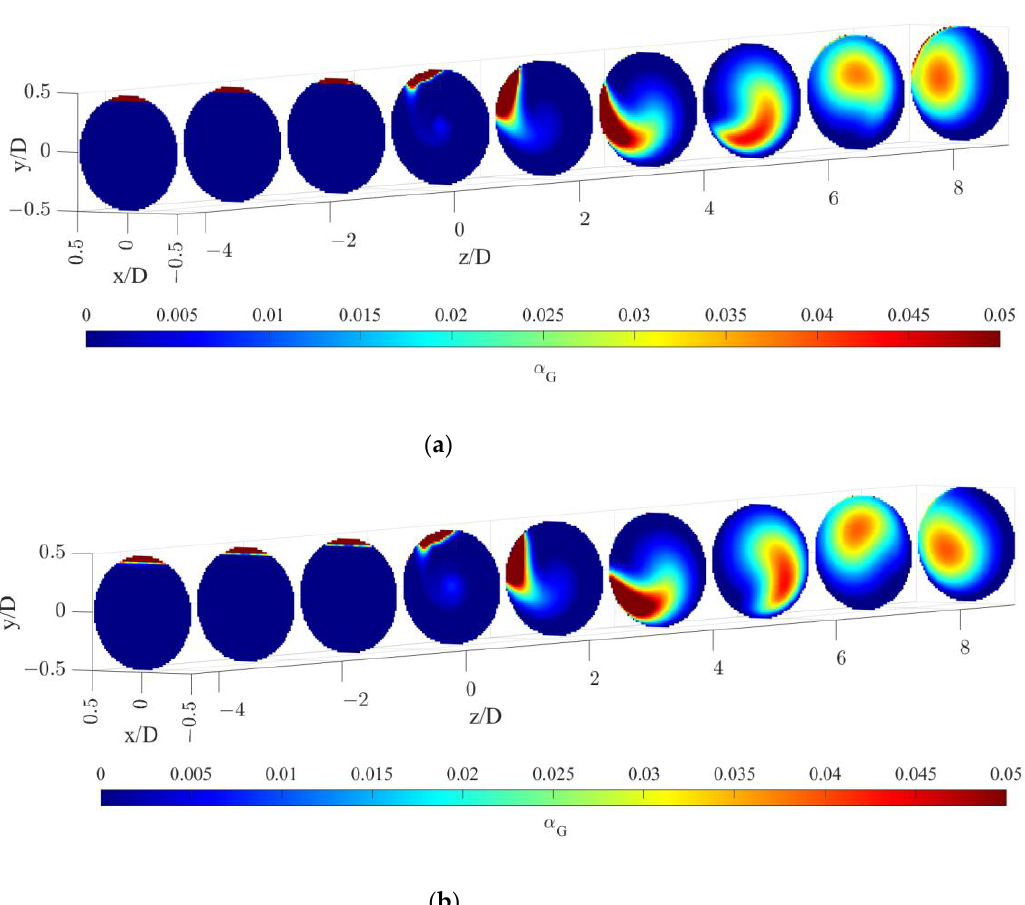
Figure 3. Gas volume fraction distribution on radial pipe cutaway surfaces for the operative condi- tions considered: ( a ) Q L = 25 m 3 /h and Q G = 3.75 L/min; ( b ) Q L = 30 m 3 /h and Q G = 7.5 L/min. The static mixer is placed at −0 .14 < z/D < 0 and the fluids are moving from left to right. The initial and final part of the pipe are omitted to improve readability.